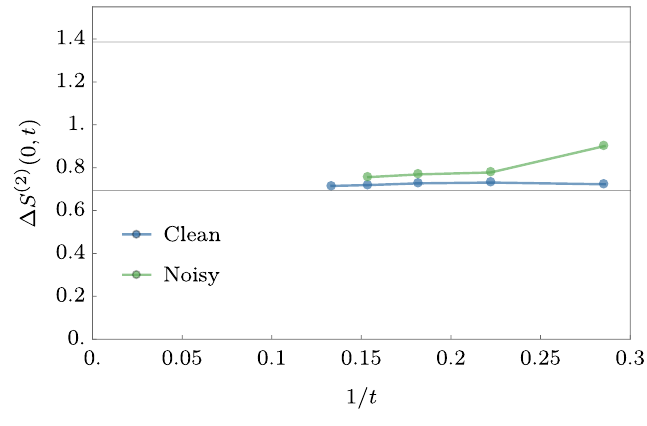
Figure 5: The slope of Rényi n = 2 entanglement entropy for the operator σ ing according to (non-dual-unitary) U ( 4 ) Haar-random gates. In the clean case we average over 10 realisations, in the noisy case over 20 (100 for t ≤ 6). The re- sults suggest that the slope is close to log2, which is half of the maximal